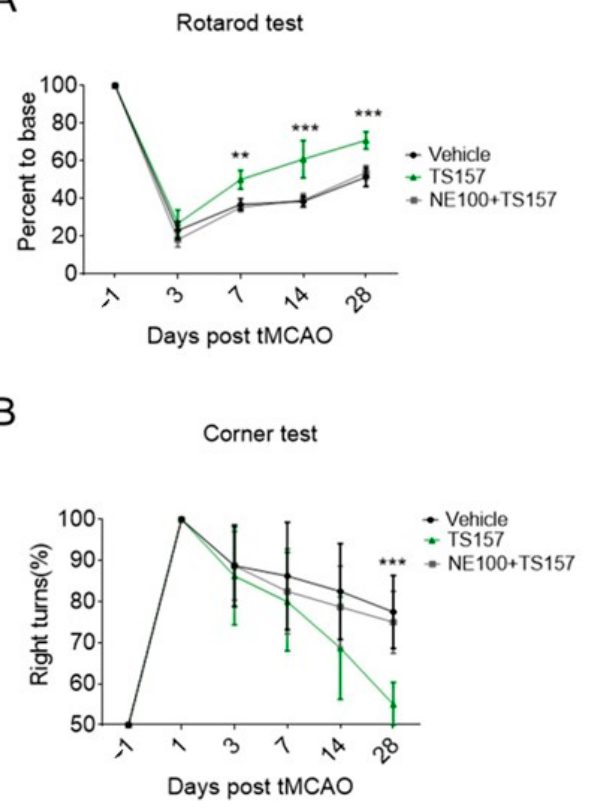
Figure 7. NE-100 reverses the recovery of motor function in tMCAO rats. ( A ) Rotarod test for tMCAO rats in control group, TS-157 group (10 mg/kg), and TS-157 plus NE-100 group (TS-157 10 mg/kg + NE-100 10 mg/kg); ( B ) corner test for tMCAO rats in above groups. Data obtained from the 8–10 mice per group are expressed as mean ± SEM. Statistically significant differences: ** p < 0.01, *** p < 0.001 ‘NE-100 + TS-157’ vs. ‘TS-157’ (two-way ANOVA followed by Bonferroni test).